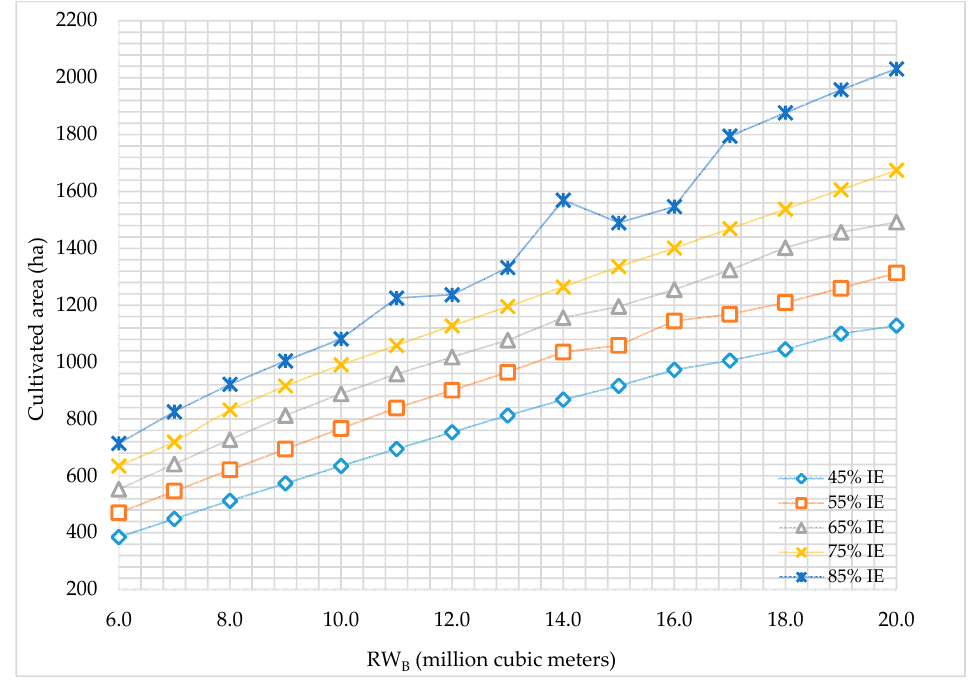
Figure 5. Total cultivated area (ha) predicted using reclaimed water type B (RW B ) with five different irrigation efficiencies (IEs).